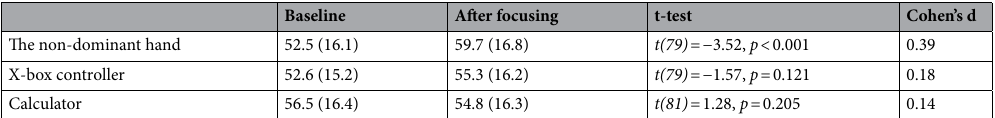
Table 1. The mean and standard deviation of ratings of the non-dominant hand and external objects, and the effect size (Cohen’s d) of the change between baseline rating and the rating after focusing on details of the hand or the X-box controller, or listening to the distraction task (calculator condition). The mean ratings and 95% confidence interval around the means are also presented in Fig.